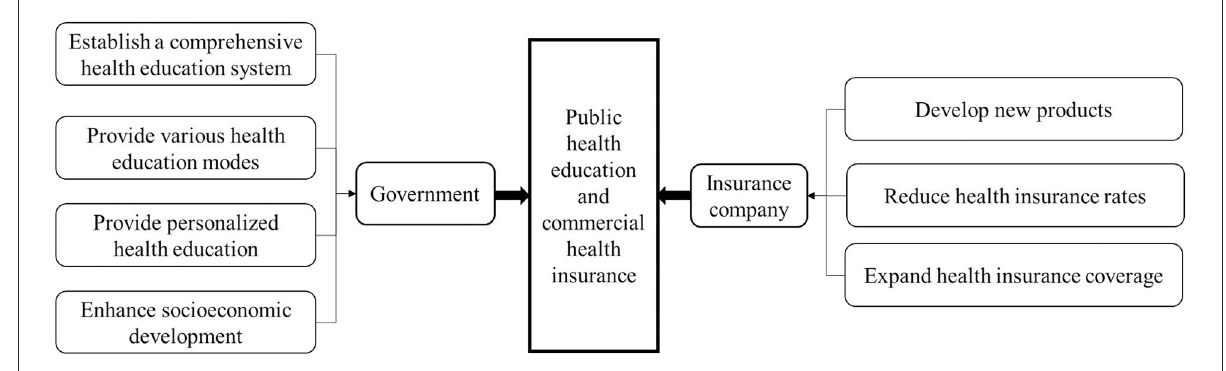
FIGURE6 Measures to improve public health education and commercial health